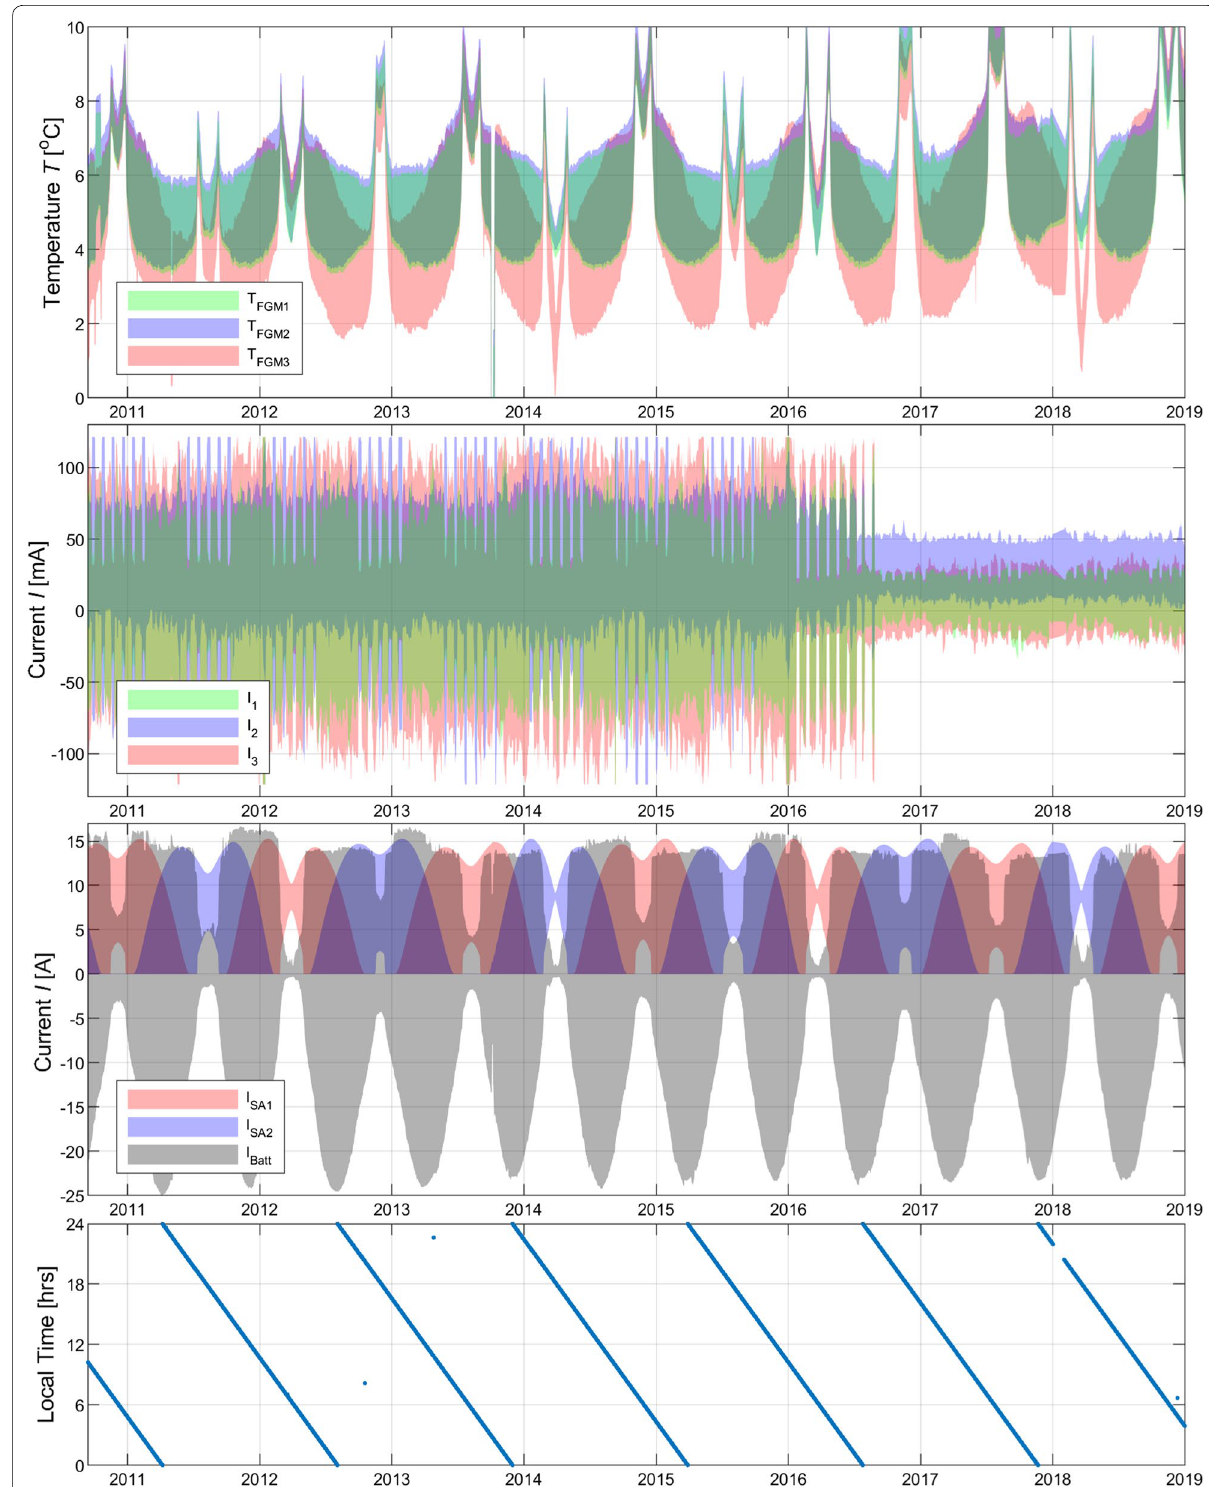
Fig. 2 From top to bottom: instrument temperature T FGM for the three magnetometers. Magnetorquer currents I MTQ . Solar array currents I SA1,2 and battery current I Batt . Shown are daily minimum/maximum values. Bottom: Local Time of ascending